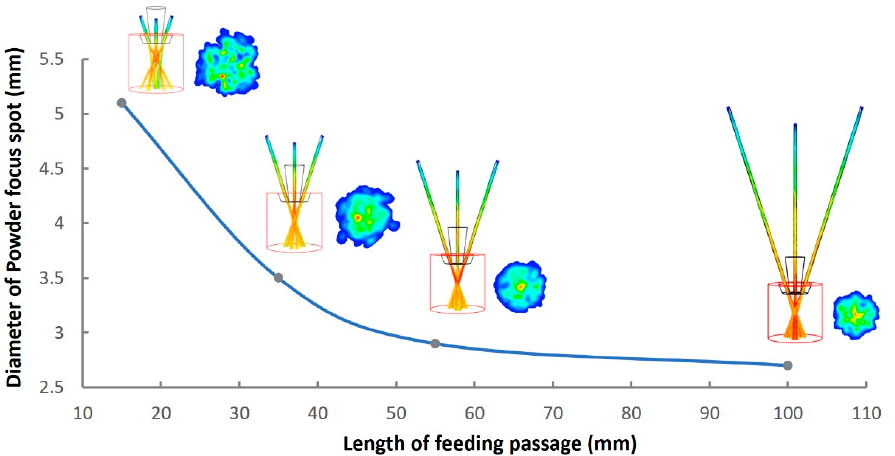
Figure 7. Influence of passage length on powder focal spot diameter.